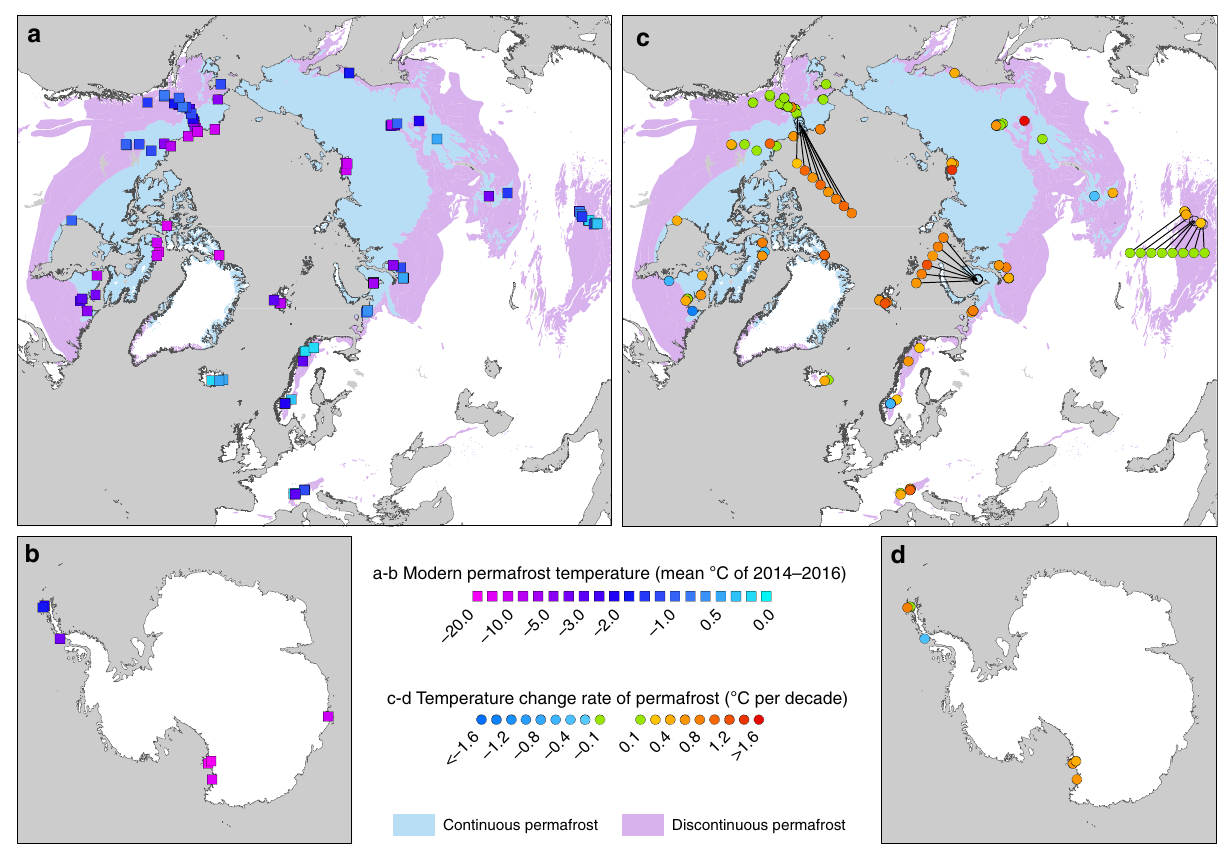
Fig. 2 Permafrost temperature and rate of change near the depth of zero annual amplitude. a , b Mean annual ground temperatures for 2014 – 2016 in the Northern Hemisphere and Antarctica, n = 129 boreholes. c , d Decadal change rate of permafrost temperature from 2007 to 2016, n = 123 boreholes (Eq. 3). Changes within the average measurement accuracy of ~±0.1 °C are coded in green. Continuous permafrost zone (>90% coverage); discontinuous permafrost zones (<90% coverage). Permafrost zones are derived from the International Permafrost Association (IPA) map 46 . World Borders data are derived from http://thematicmapping.org/downloads/world_borders.php and licensed under CC BY-SA 3.0 (https://creativecommons.org/licenses/by-